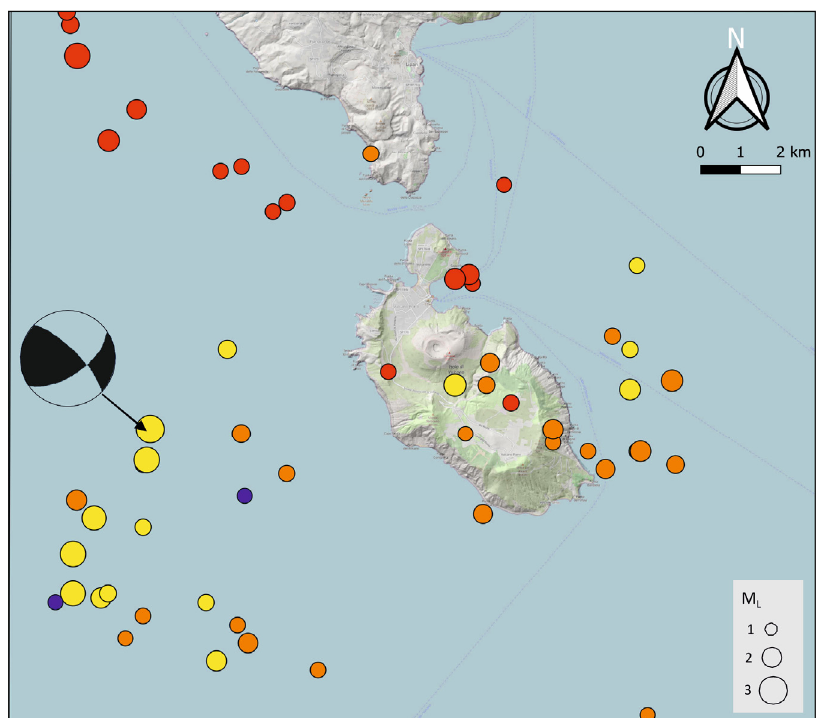
Figure 17. Epicentral map of the ML ≥ 1 earthquakes recorded in the Vulcano area (coordinates 38.32N–14.84E and 38.48N–15.07E) from 1 June 2020 to 30 April 2022. The color of the circles depends on the depth of the earthquakes (red circles H ≤ 5 km; orange 5 < h ≤ 10 km; yellow 10 < h ≤ 15; blue > 15 km). The fault plane solution of the earthquake that occurred on 31 May 2021 at 1:16 pm is also reported. The source of the background map is openstreetmap.org/copyright (QGIS software).